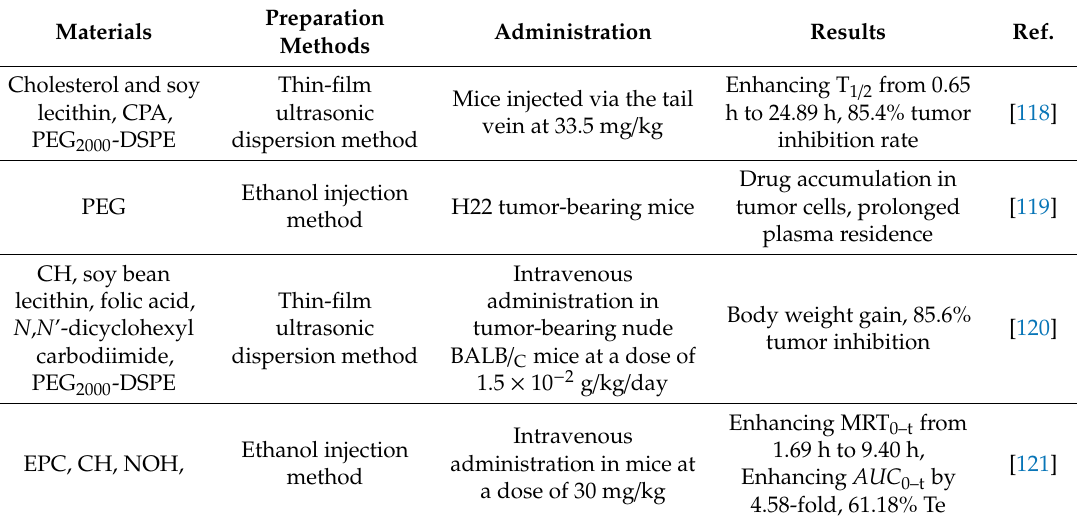
Table 4. Examples of ORI-loaded